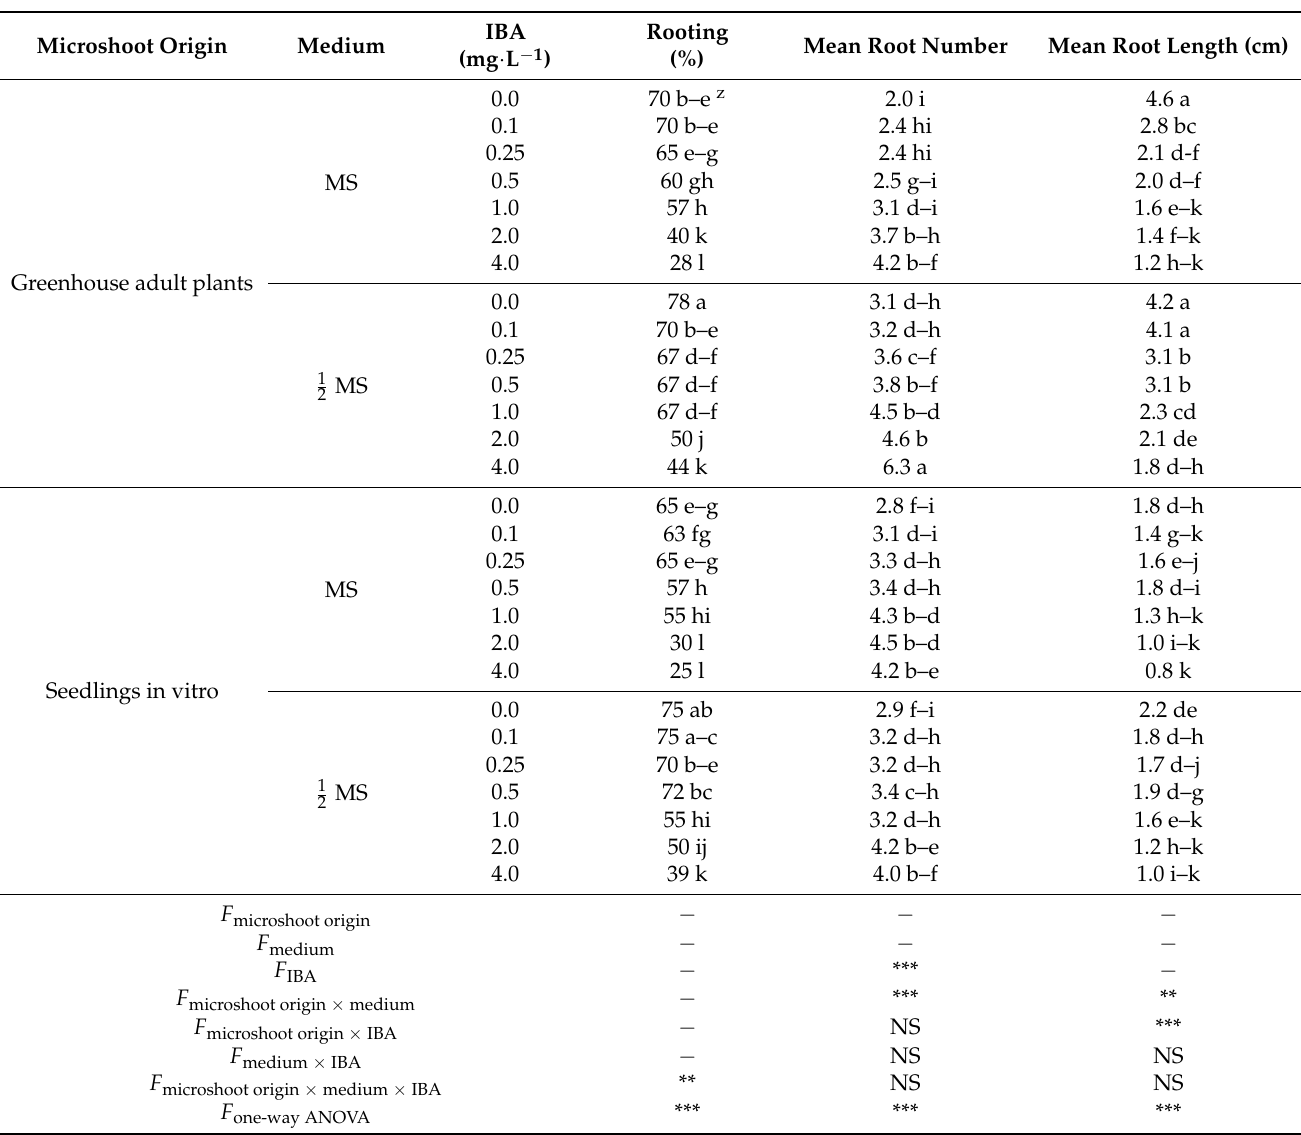
Table 5. Effect of microshoot origin, growth medium and IBA concentration on in vitro rooting of S. tomentosa microshoots. The microshoots were produced on MS medium with 0.4 mg L − 1 BA and 0.01 mg L − 1